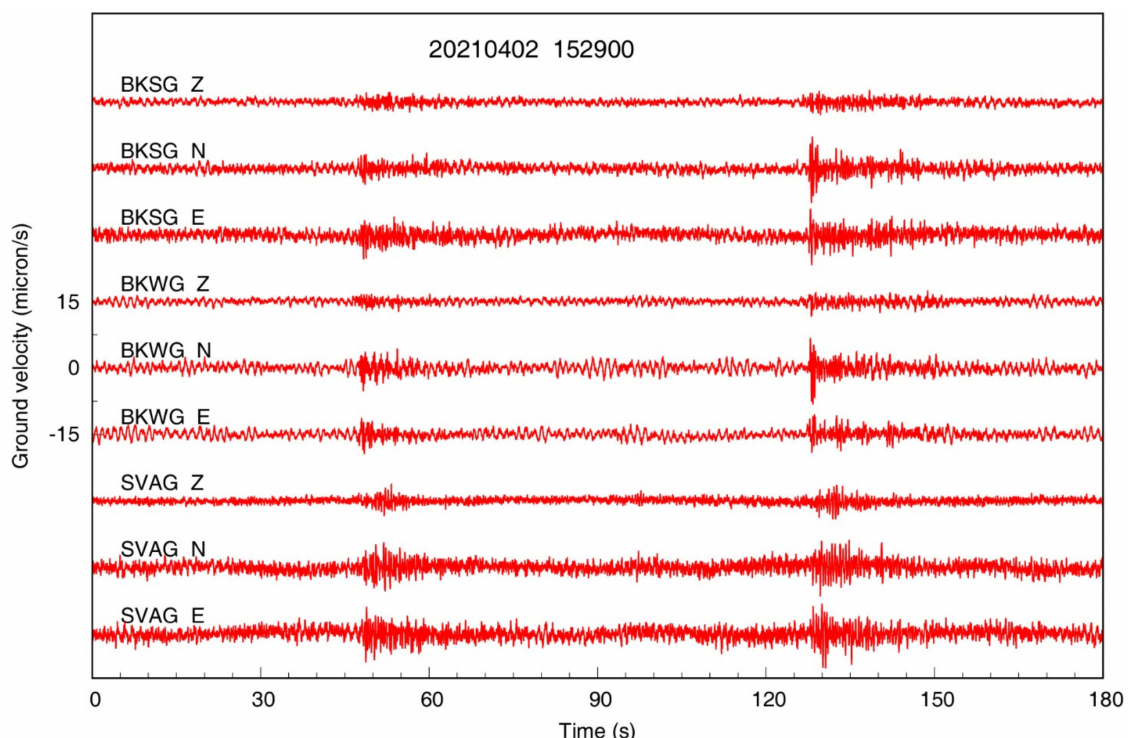
Figure 8. Two low-frequency earthquakes recorded at stations BKSG and BKWG.